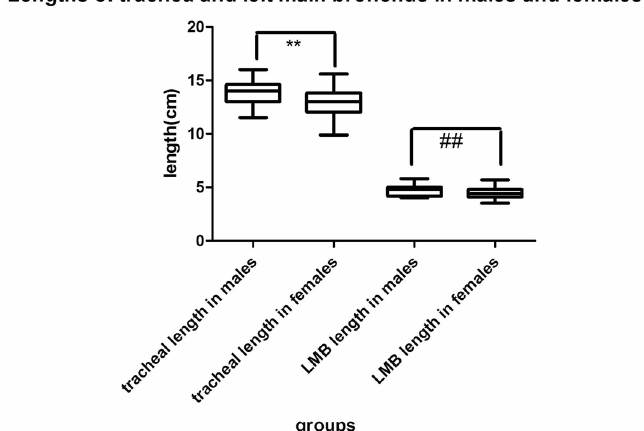
Figure 1. Lengths of trachea and left main bronchus in males and females. The lengths of the trachea and left main bronchus are significantly longer in males than those in females. (LMB left main bronchus;** represent the comparison the length of trachea between males and females.*, P < 0.05; **, P < 0.01. # represent length of left main bronchus compare to males and females. #, P < 0.05; ##, P < 0.01).